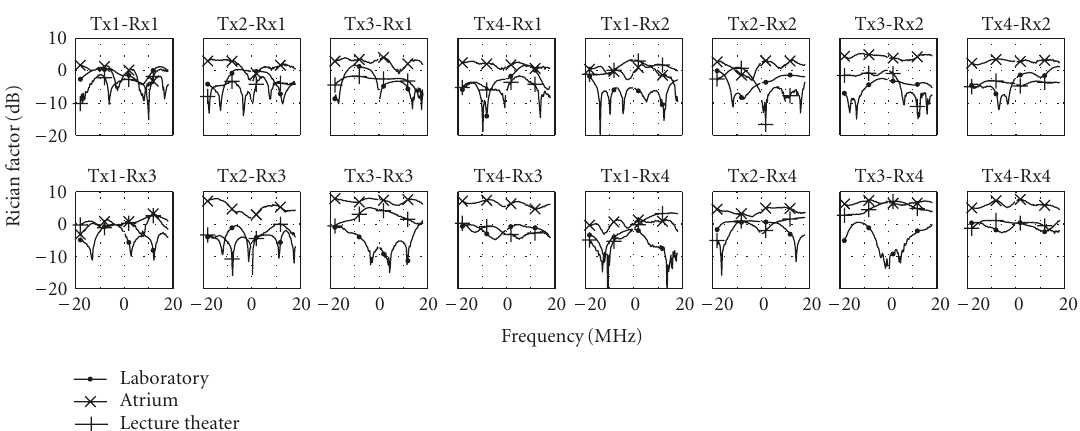
Figure 6: Measured Rician factor for LoS paths in the laboratory, atrium, and lecture theater.